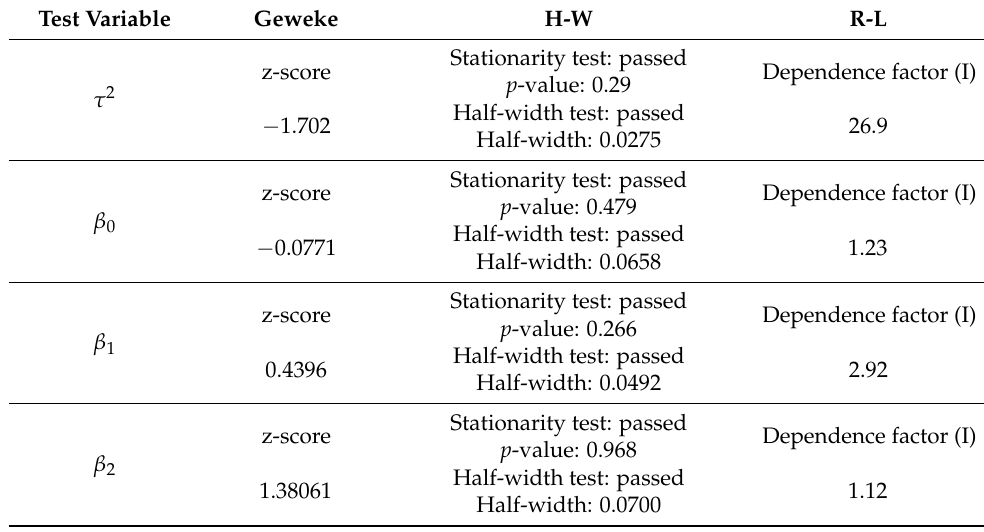
Table 6. The MCMC convergence diagnostics for τ 2 , β 0 , . . . , β 7 using the Geweke, H–W, and R–L tests (the simulated effect sizes) by using log-logistic distribution for τ 2